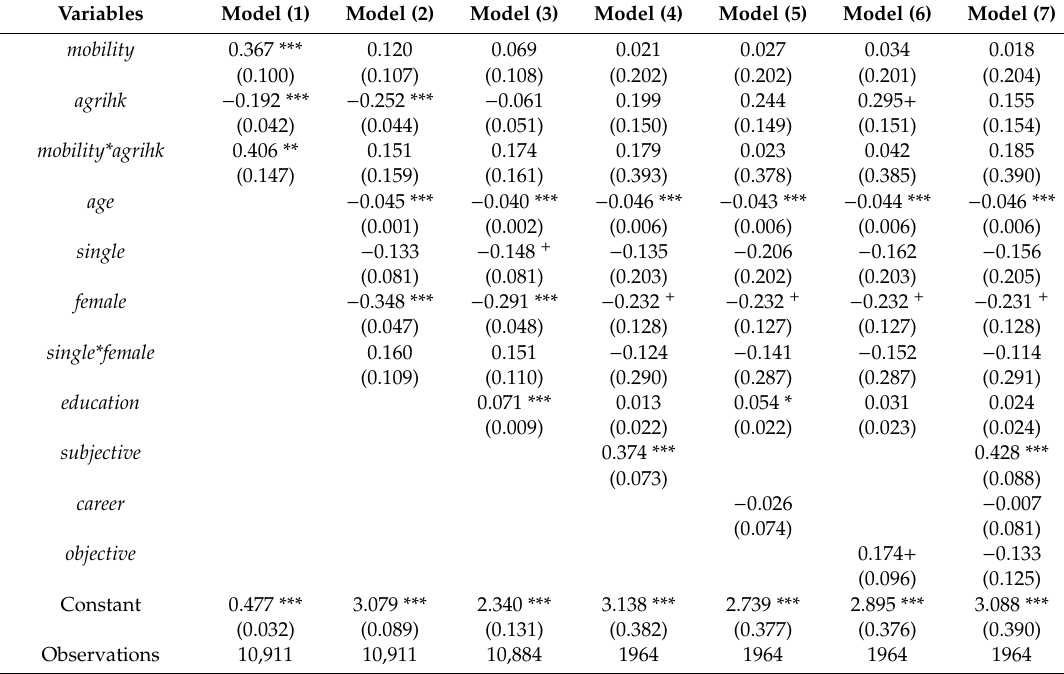
Table 12. The result of mixed-e ff ect logit regression with a random